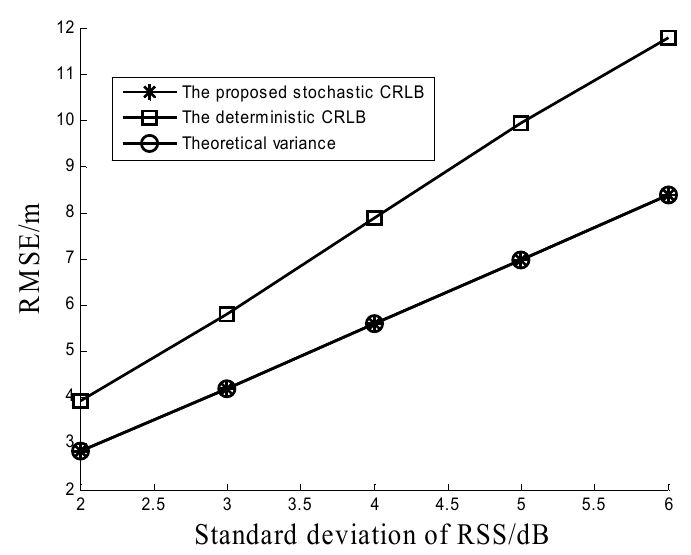
Figure 4. Comparison among the proposed stochastic CRLB, the deterministic CRLB, and the theoretical variance of the proposed method under different RSS noises.